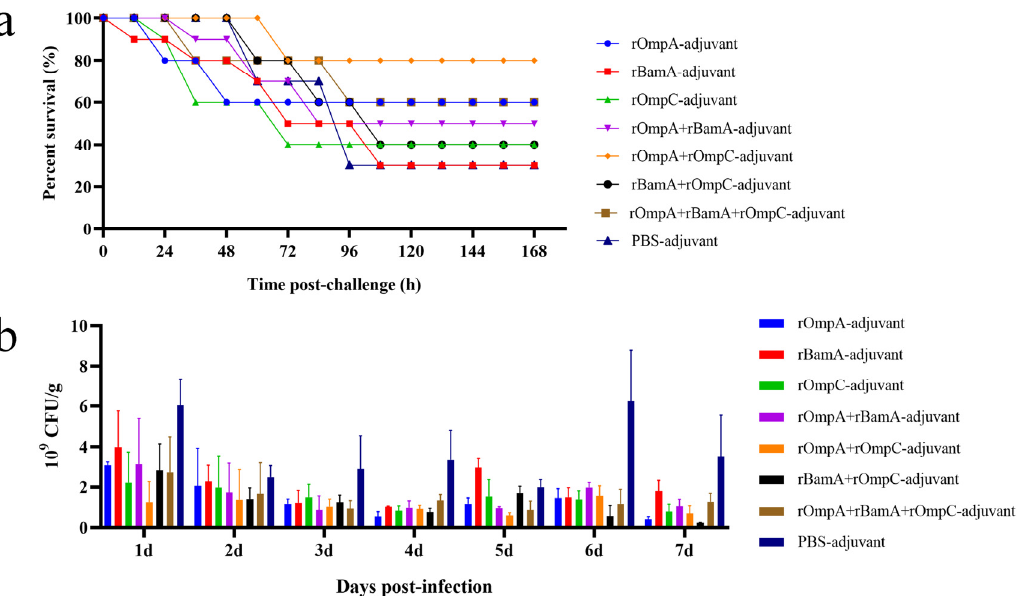
Figure 6. Protection efficacy of the recombinant proteins against E. coli in vivo. ( a ) Immunized mice were intraperitoneally injected with mid-log phase E. coli O78 (CVCC CAU0768); survival rate was observed for 168 h after the challenge. ( b ) Immunized mice were challenged with mid-log phase E. coli O157 (CICC 21530) by gastric tube, and fecal shedding was observed for seven days after the challenge, data are expressed as the means ± SD, n = 3.